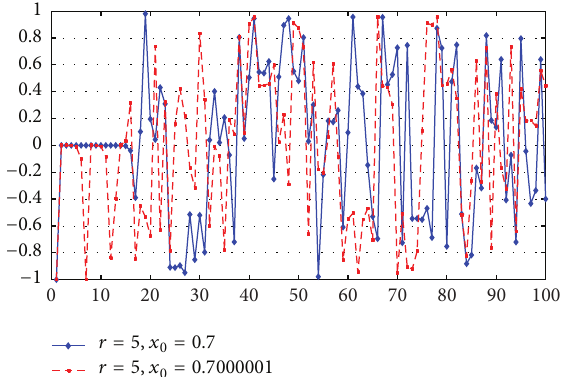
Figure 2: The sensibility of the 𝑓 𝑟 map to changes of the initial point 𝑥 0 .